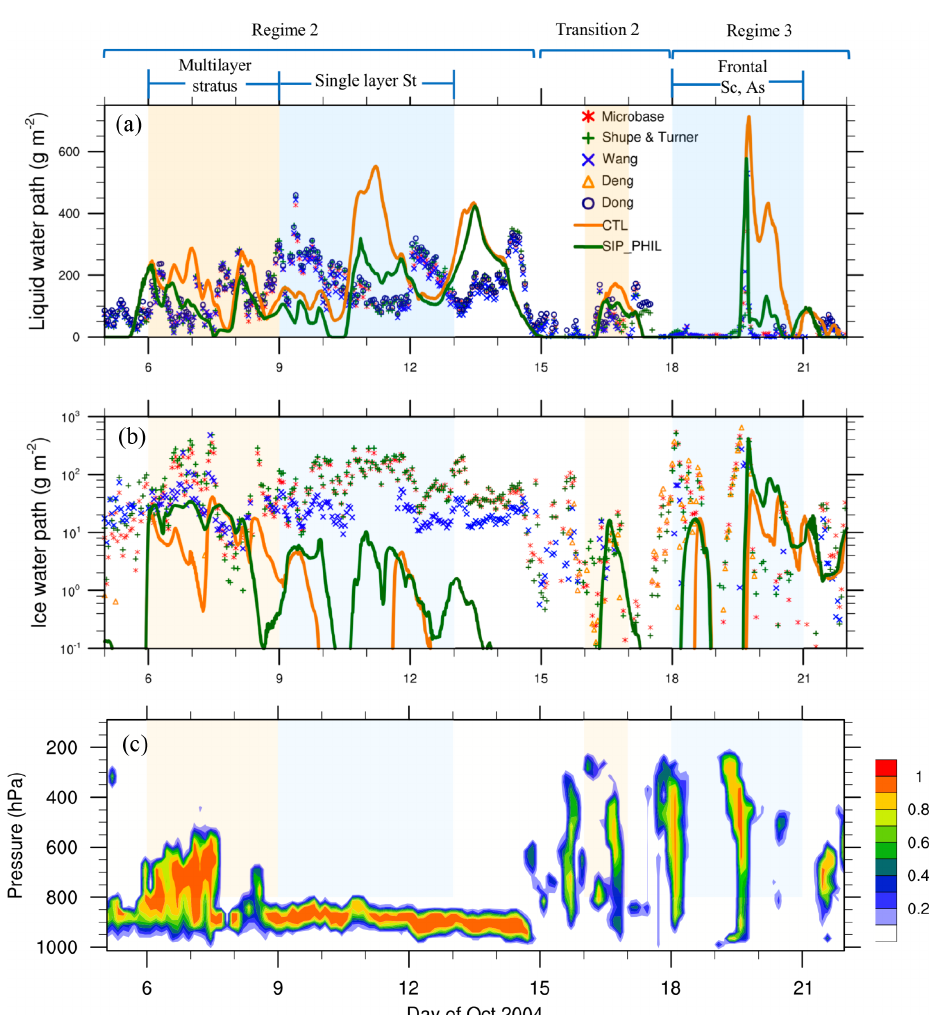
Figure 4. Temporal evolution of (a) LWP, (b) IWP from remote sensing retrievals shown by different markers, CTL experiment (solid orange line) and SIP_PHIL experiment (solid dark green line), and (c) observed time–pressure cross section of the cloud fraction. The shadings show the multilayer stratus, single-layer stratus, transition, and frontal